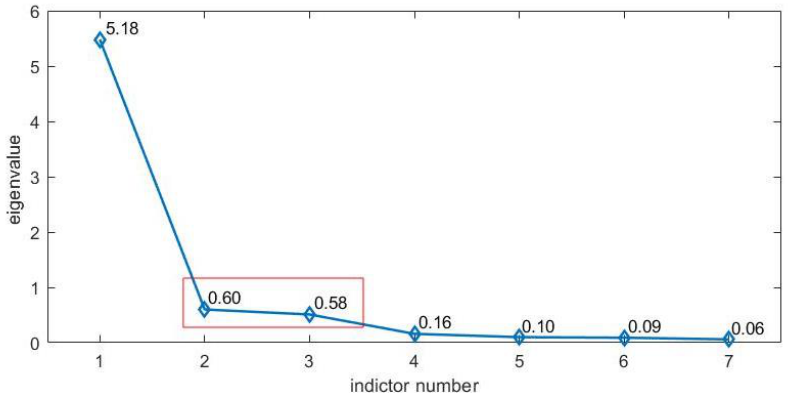
Figure 3. Scree plot for indicator group size selection.